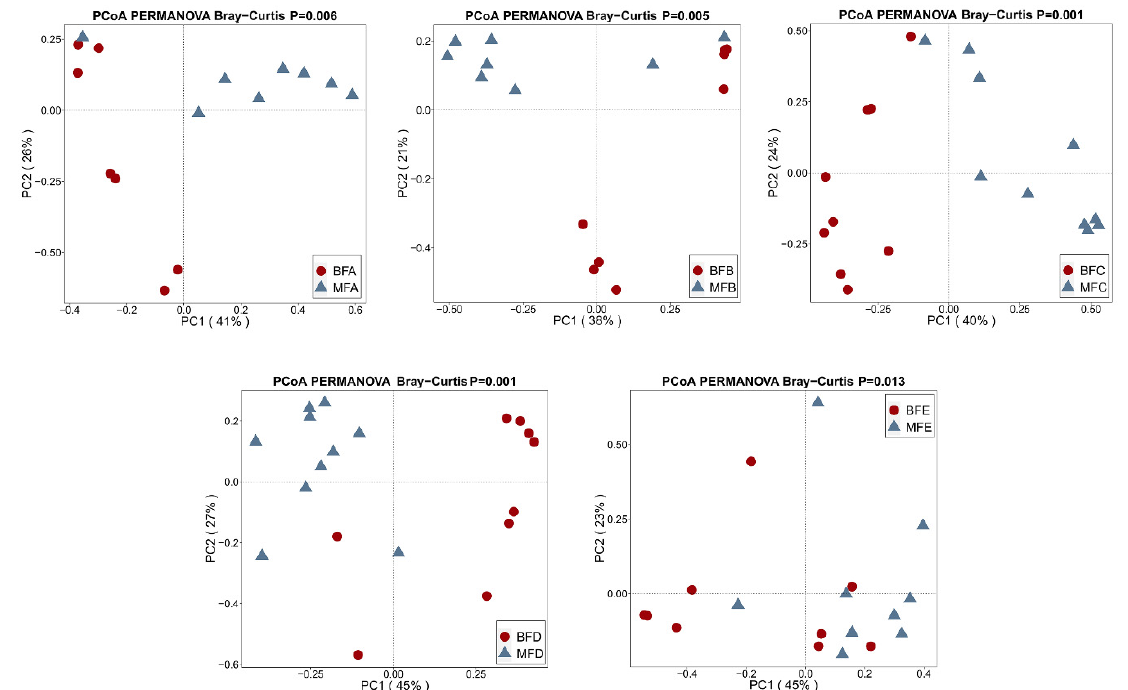
Figure 7. Beta-diversity illustrating of Bifidobacterium community between maternal and infant feces. PERMANOVA was used to calculate the difference among samples based on Bray–Curtis distance. p < 0.05 stands for significantly different microbiota composition was found among samples. MFA: maternal feces (corresponding to infant younger than one month of age), MFB: maternal feces (corresponding to infant between one and three months of age), MFC: maternal feces (corresponding to infant between three and six months of age), MFD: maternal feces (corresponding to infant between six and 12 months of age), MFE: maternal feces (corresponding to infant older than 12 months of age), BFA: infant feces younger than one month of age, BFB: infant feces between one and three months of age, BFC: infant feces between three and six months of age, BFD: infant feces between six and 12 months of age, BFE: infant feces older than 12 months of age.